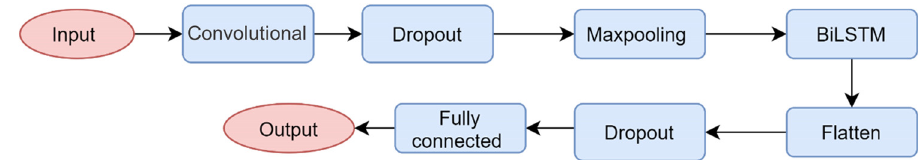
Figure 8: The CNN - BiLSTM